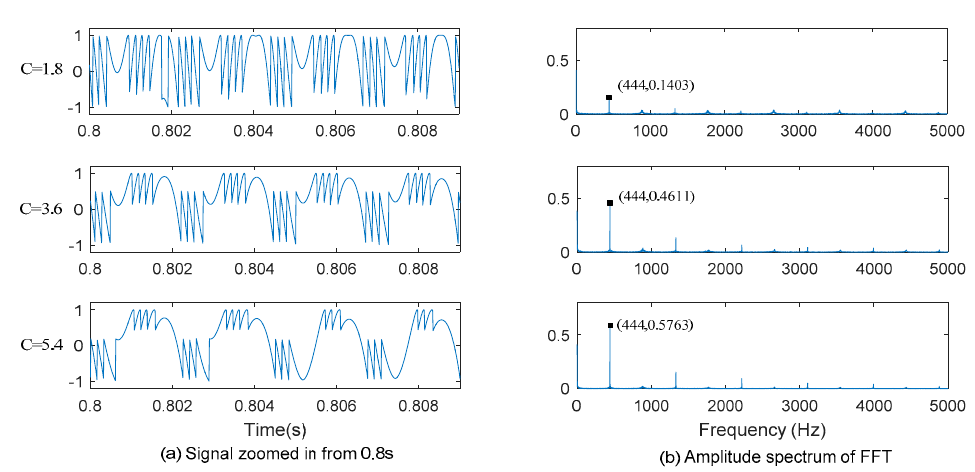
Figure 7. FFT spectrum of ( ) G t under different feedback level. ( a ) Signal zoomed in from 0.8 s ( b ) Amplitude spectrum of FFT.